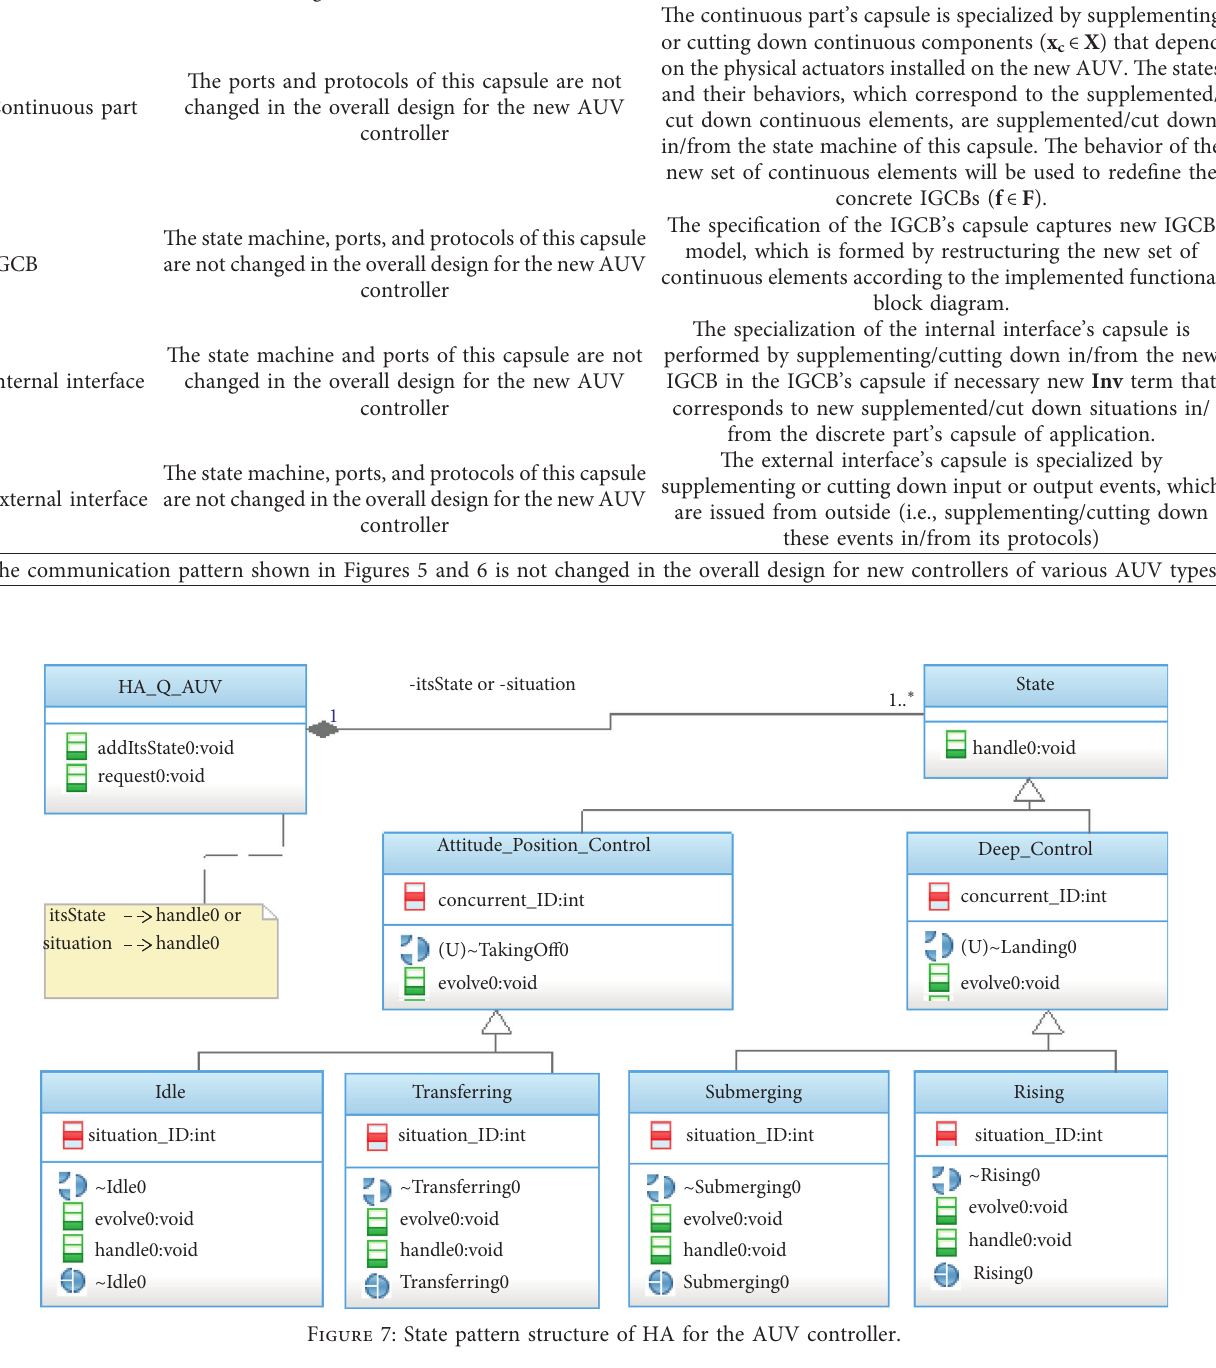
Table 2: Main control capsules of the PIM can be customized and reused in the new control application for various AUV types. Designed control capsules Specialized artifacts